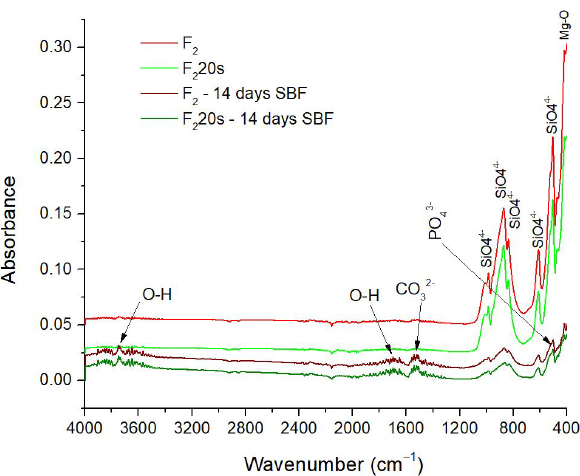
Figure 14. FTIR Spectra of F 2 , F 2 20s before and after 14 days in SBF.